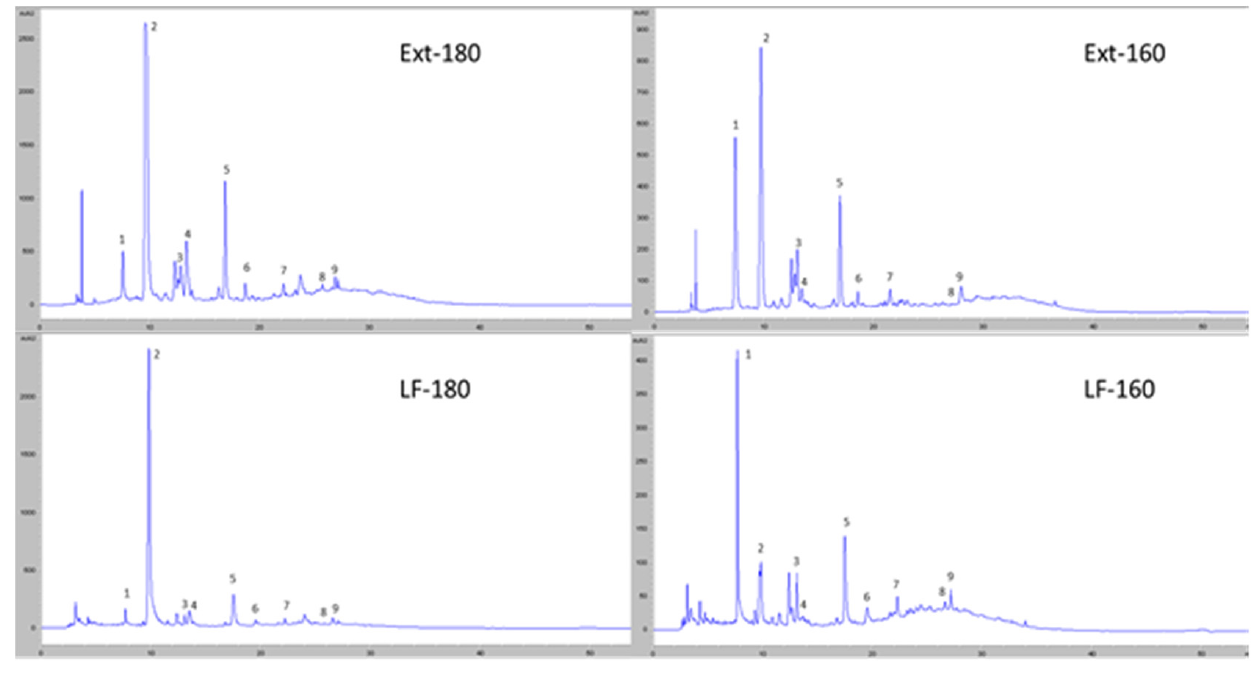
Figure 3. Chromatographic profile obtained by HPLC-DAD at 280 nm of the liquid fractions obtained from the hydrothermally treated date seeds at 160 ◦ C (LF-160) and 180 ◦ C (LF-180), their phenolic extracts (Ext-160 and Ext-180), and the main compounds detected: 1: gallic acid, 2: hydroxymethylfurfural, 3: protocatechuic acid, 4: furfural, 5: vanillic acid, 6: p-hydroxybenzoic acid, 7: syringic acid, 8: luteolin, and 9: quercetin.